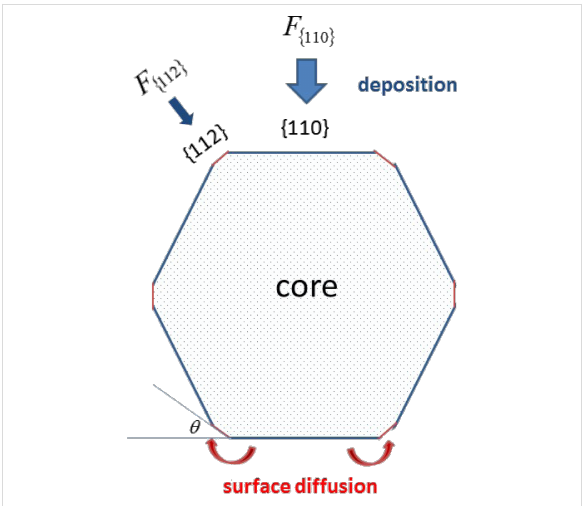
Figure 2: Schematic of cross section of a core of a nanowire that is a six-fold symmetric structure with {112} facets along the corners of the hexagonal core. The lengths of the facets are l {112} and l {110} , respec- tively. In this structure, the angle θ between a {110} facet and its neigh- boring {112} facet is π